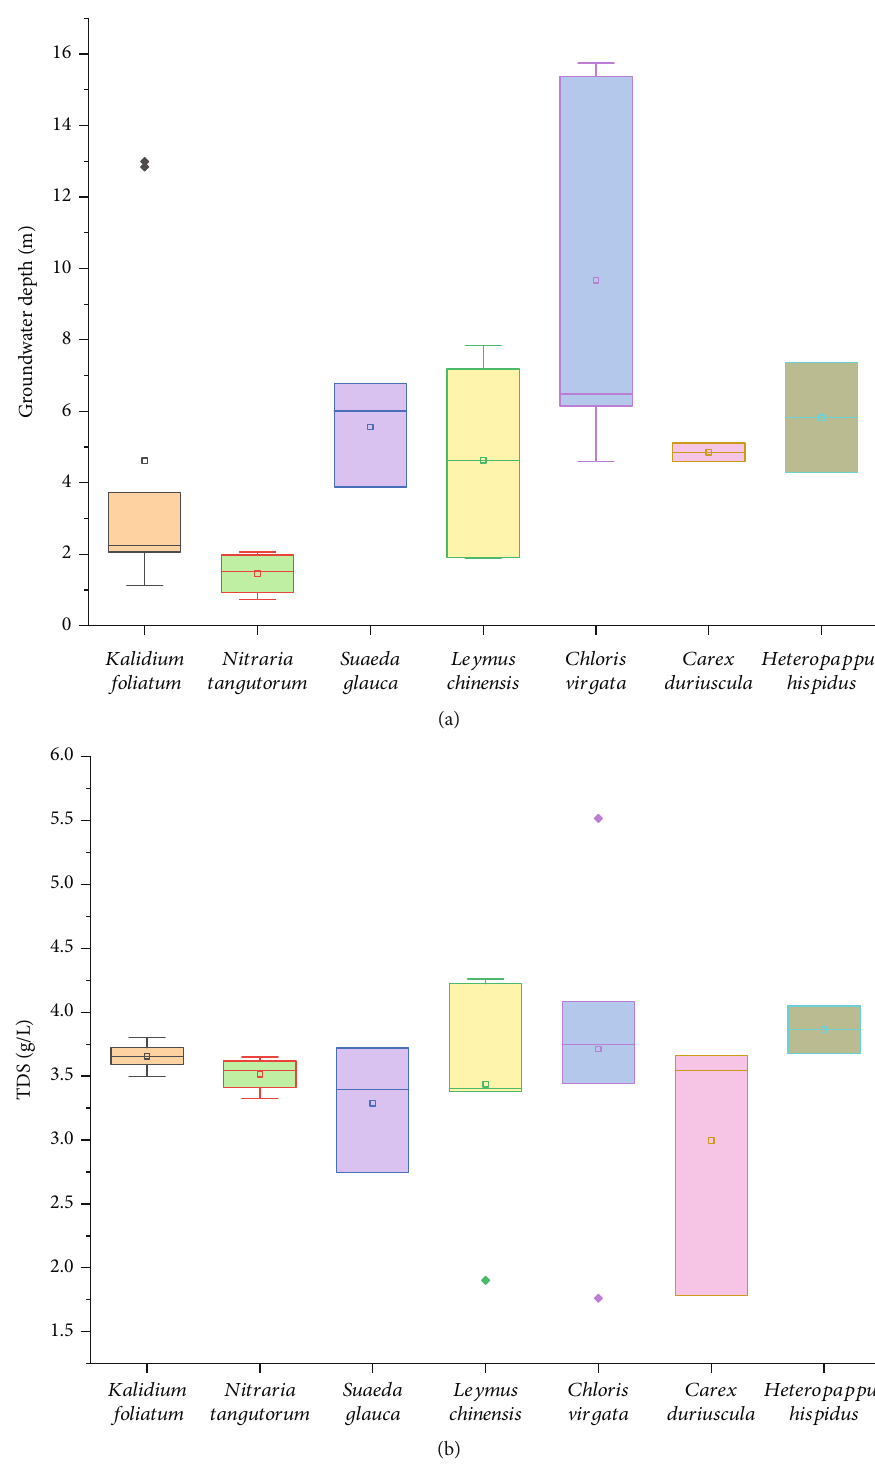
Figure 4: Relationship between groundwater characteristics and natural vegetation: (a) groundwater depth; (b)